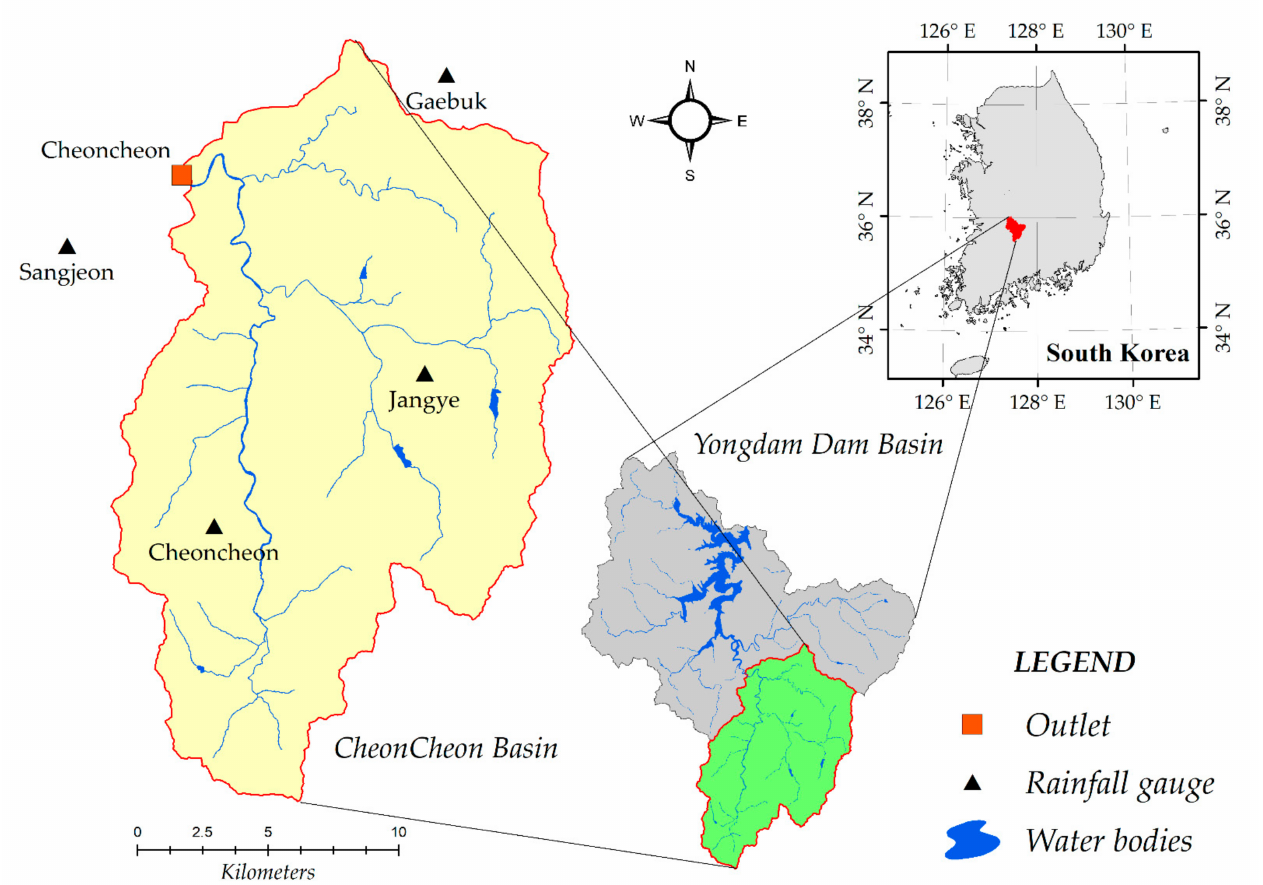
Figure 2. Location of the Cheoncheon